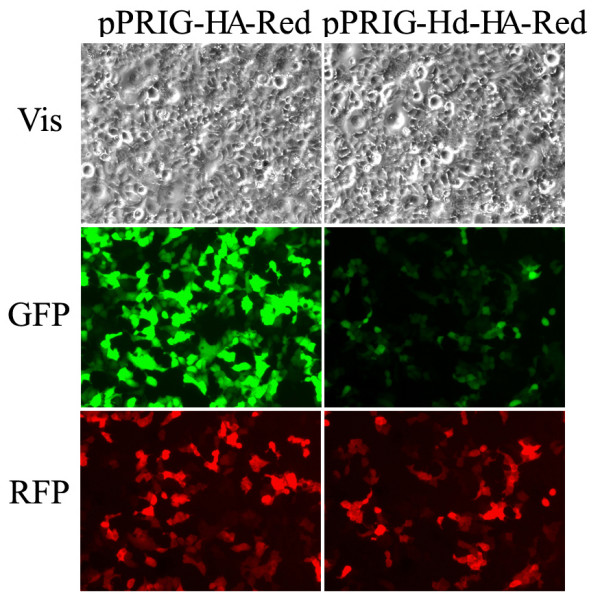
Comparison of transient pPRIG-HA-Red and pPRIGw-HA-Red expressions. HEK 293T cells were transfected with each vector, and the cells were photographed 48 h later. Vis: phase contrast image. Exposure time is the same for the two GFP images, and for the two RFP images. Fluorescence signals are thus a direct reflection of protein expression levels.